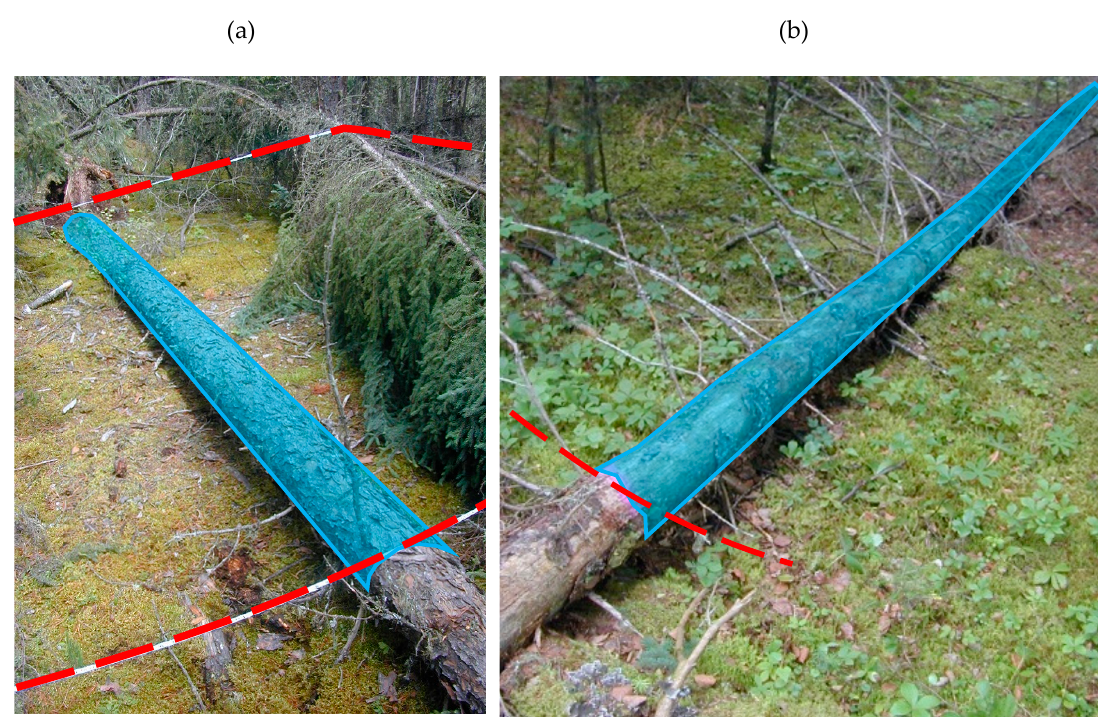
Figure A4. Measuring strategy for CWD partly outside the sampling area. Only the (blue) segment within the area is measured, as if it ended at the edge of the sampling area. The dashed red lines represent tape used in ( a ) disturbance plots or biodegradable paint used in ( b ) forest plots to mark the edges of the plots.